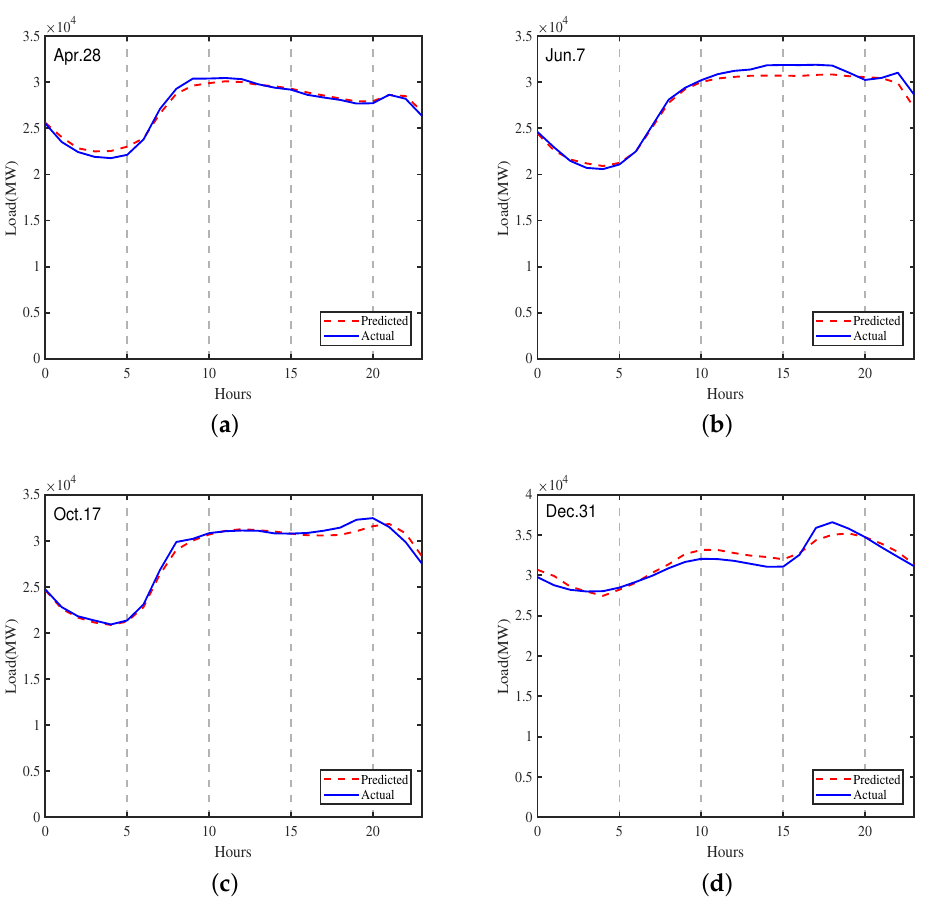
Figure 4. Predicted load and actual load for test days of PJM 2000. ( a ) Prediction for 28 April; ( b ) Prediction for 7 June; ( c ) Prediction for 17 October; ( d ) Prediction for 31 December.